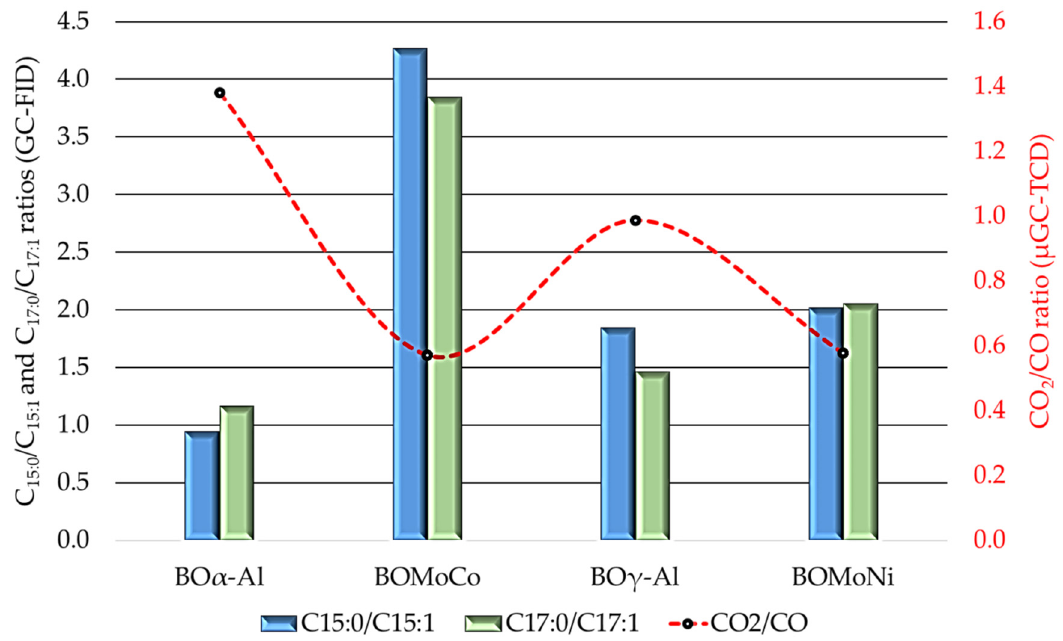
Figure 10. Comparison of the selectivity toward relevant products displayed by the catalysts and supports tested in the decarboxylation/decarbonylation of FFA, by means of representative product ratios (C 15:0 /C 15:1 , C 17:0 /C 17:1 and CO 2 /CO).